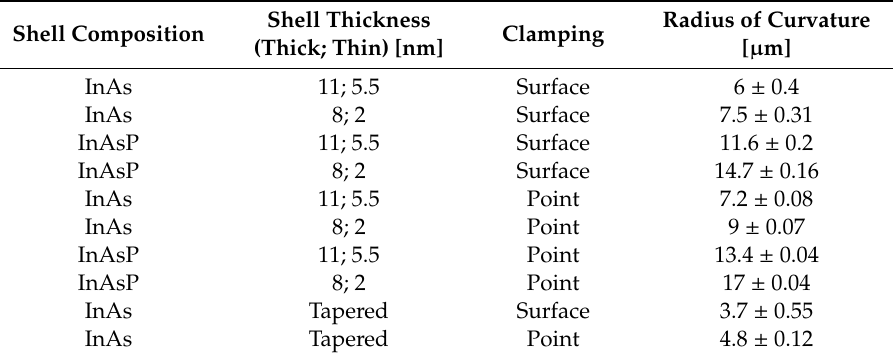
Table 1. COMSOL results for the relaxed radius of